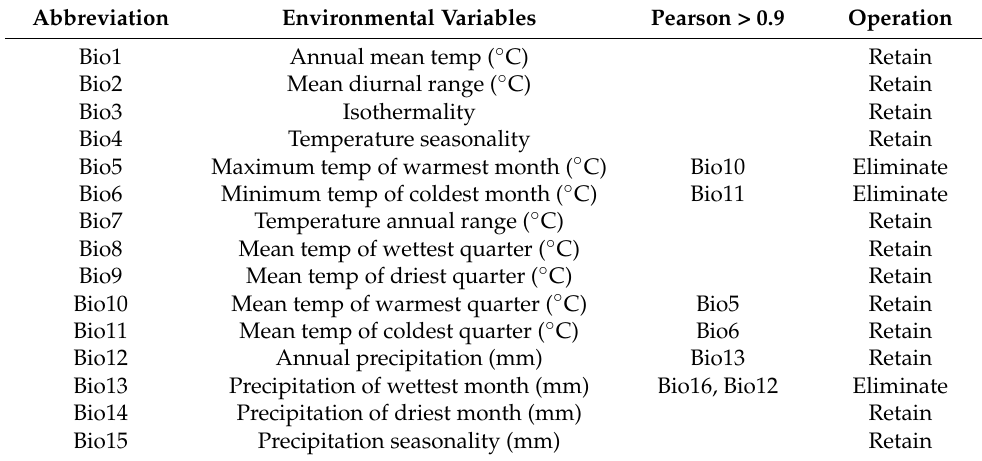
Table 1. Correlation analysis and screening of environmental